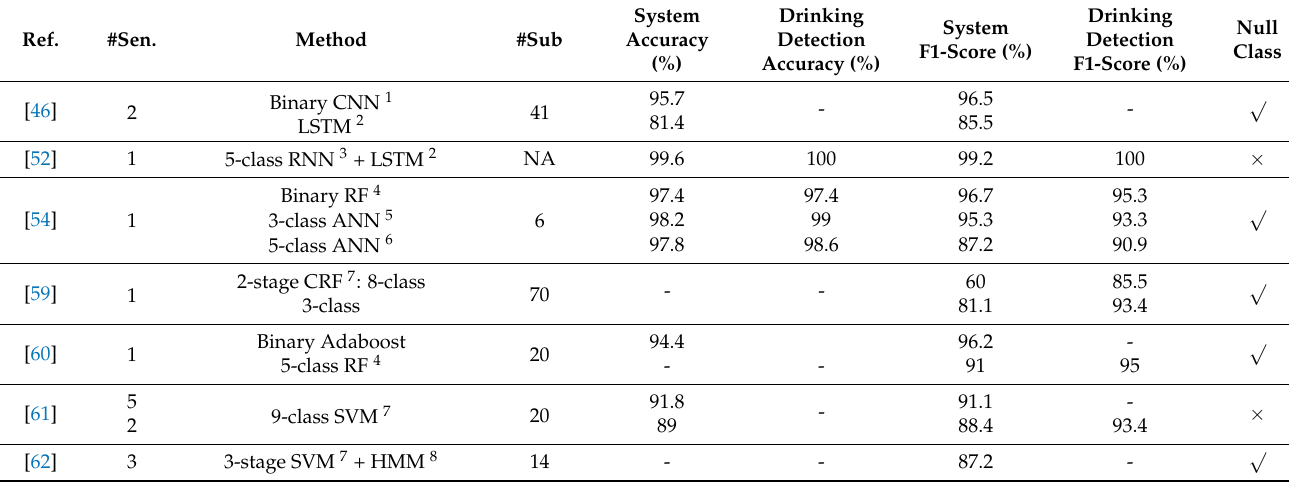
Table 1. Summary of the top seven wearable literature, where #Sen. corresponds to the number of sensors used and #Sub. corresponds to the number of subjects in the study. The system accuracy denotes the overall average accuracy when classifying all actions. The drink detection accuracy shows the accuracy for detecting the drinking action only. The same is applied for the